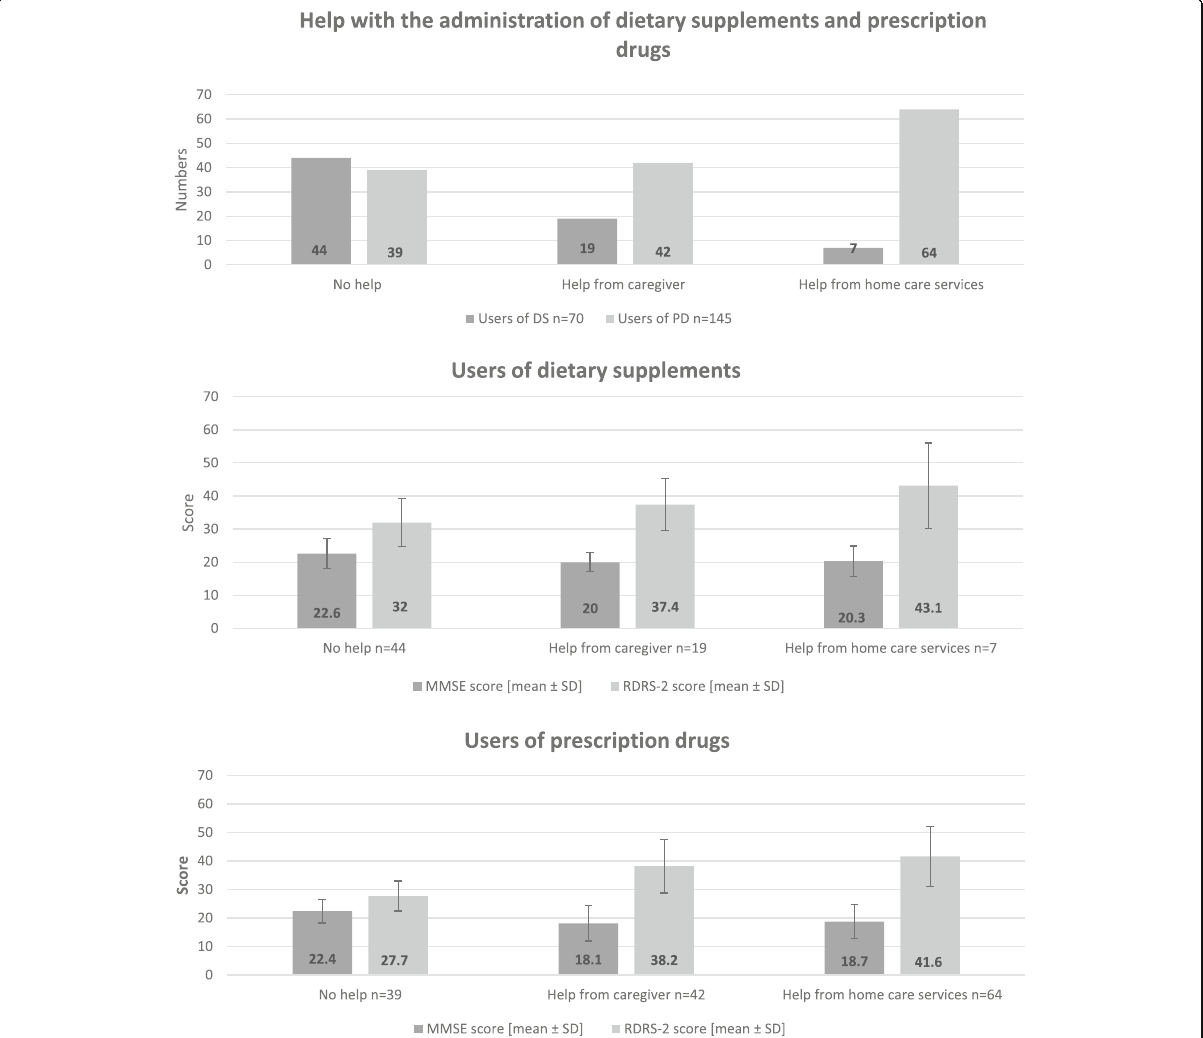
Fig. 2 Assistance with administration of dietary supplements and prescription drugs related to function. Abbrevation : DS , dietary supplements; PD , prescription drugs; ADL , activities of daily living; MMSE-NR , Mini Mental State Examination-Norwegian Revision; RDRS-2 , Rapid Disability Rating Scale-2; SD , standard deviation. Two persons with dementia, who used only vitamin B12 injection, were not included in the 145 persons that used PD, as they were not dependent of daily assistance. Note that Fig. 2 demonstrate descriptive data. The RDRS-2 scale range from 21 to 84, where a score of 21 points indicates normal function in activities of daily living and a score of 84 points indicate complete dysfunctionality. The MSEE-NR scale range from zero to 30, where 30 points indicate normal cognitive